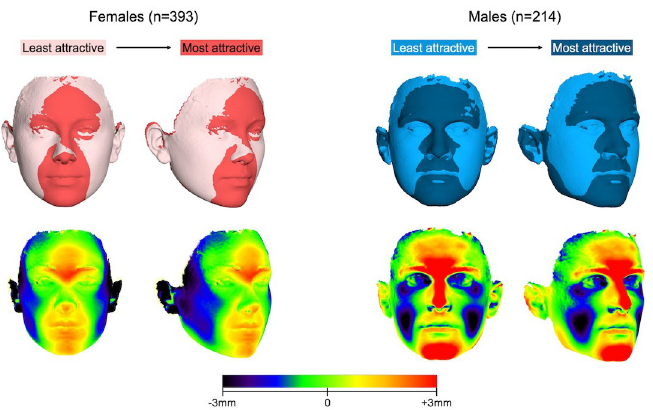
Fig 7. Best fit superimpositions showing the surface differences between the least and most attractive variation of a female (upper row, left) and male (upper row, right) face. The magnitude of difference between the two surface images can be visualized on the color maps (lower row), where distances between the most attractive and the least attractive face are shown (positive: forward).